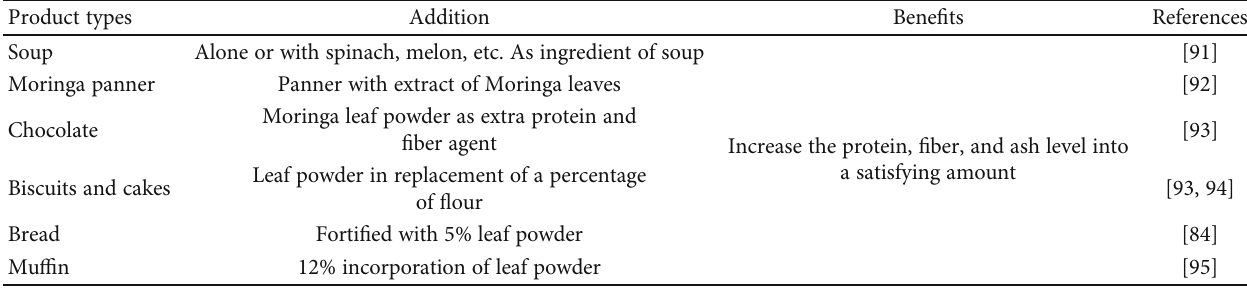
Table 9: Moringa incorporation in di ff erent food